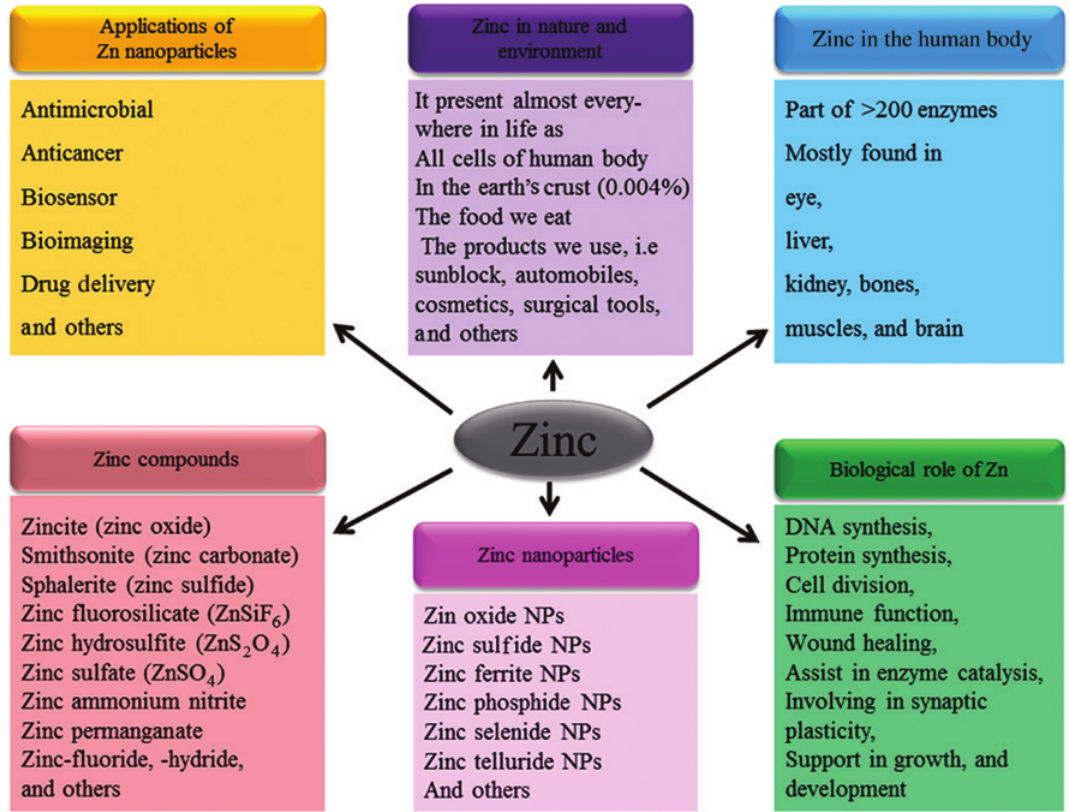
Figure 1: General description of zinc metal and zinc NPs concerning synthesis, applications, and